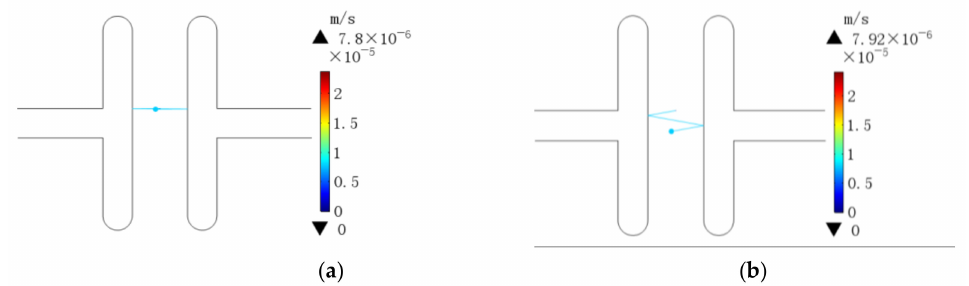
Figure 6. Motion simulation of cellulose and copper particles in natural ester under DC electric field. ( a ) Cellulose particles, ( b ) Copper